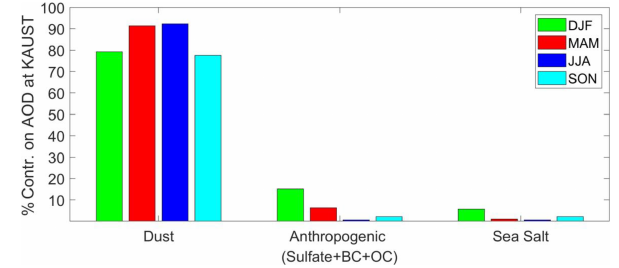
Figure 5. Percentage contribution of different aerosol types to total AOD at KAUST as simulated by